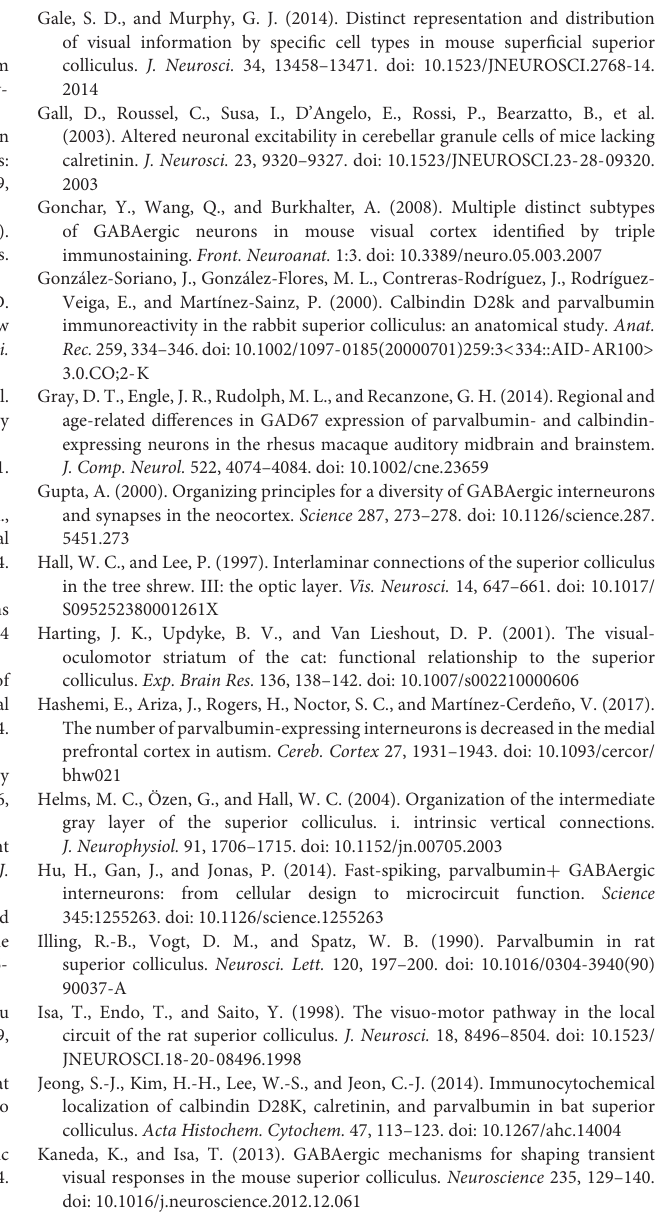
neuron in iSC (white arrow) of a brain slice from the Ai32;PV-Cre mouse. Scale: 20 µ m. (B) DIC image showing the location of the recorded PV + neuron. Scale: 200 µ m. (C) Upper panel: Schematic illustration showing the recording of PV − (1) and PV + (2) neurons in the iSC. Bottom panel: Representative traces of a recorded PV − neuron showing no significant current evoked upon 2 ms light stimulation in voltage-clamp configuration. Note the spontaneous IPSC evoked long after the light pulse when voltage is held at − 20 mV (white arrow). Scale: 10 pA/5 ms. (D) Light stimulation elicited in a PV + neuron a large and short latency APV/CNQX-insensitive inward current at − 80 mV. Application of 1 µ M TTX eliminated the inward current. The recording pipette contained QX-314 hence the absence of spikes. Scale: 100 pA/5 ms. (E) Light pulses of increasing length failed to evoke PSCs in iSC PV − neurons at either − 80 mV or − 20 mV V m . (F) a train of 10 light pulses (5 ms in length) failed to evoke PSCs in iSC PV − neurons. Five consecutive traces are